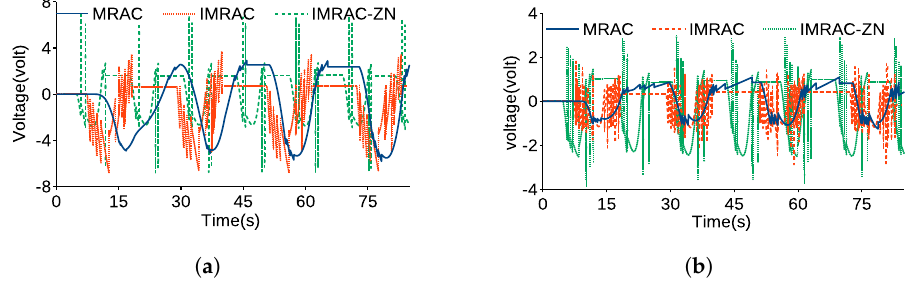
Figure 10. Actual voltage of each joint. ( a ) hip; and ( b ) knee.